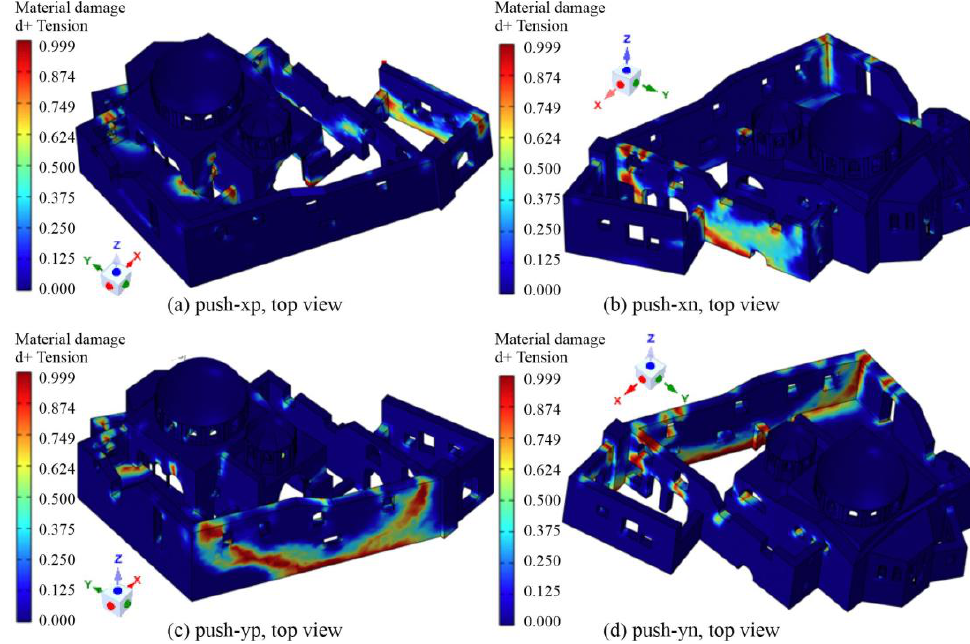
Figure 22. Material damages in the perimeter walls under lateral loads.